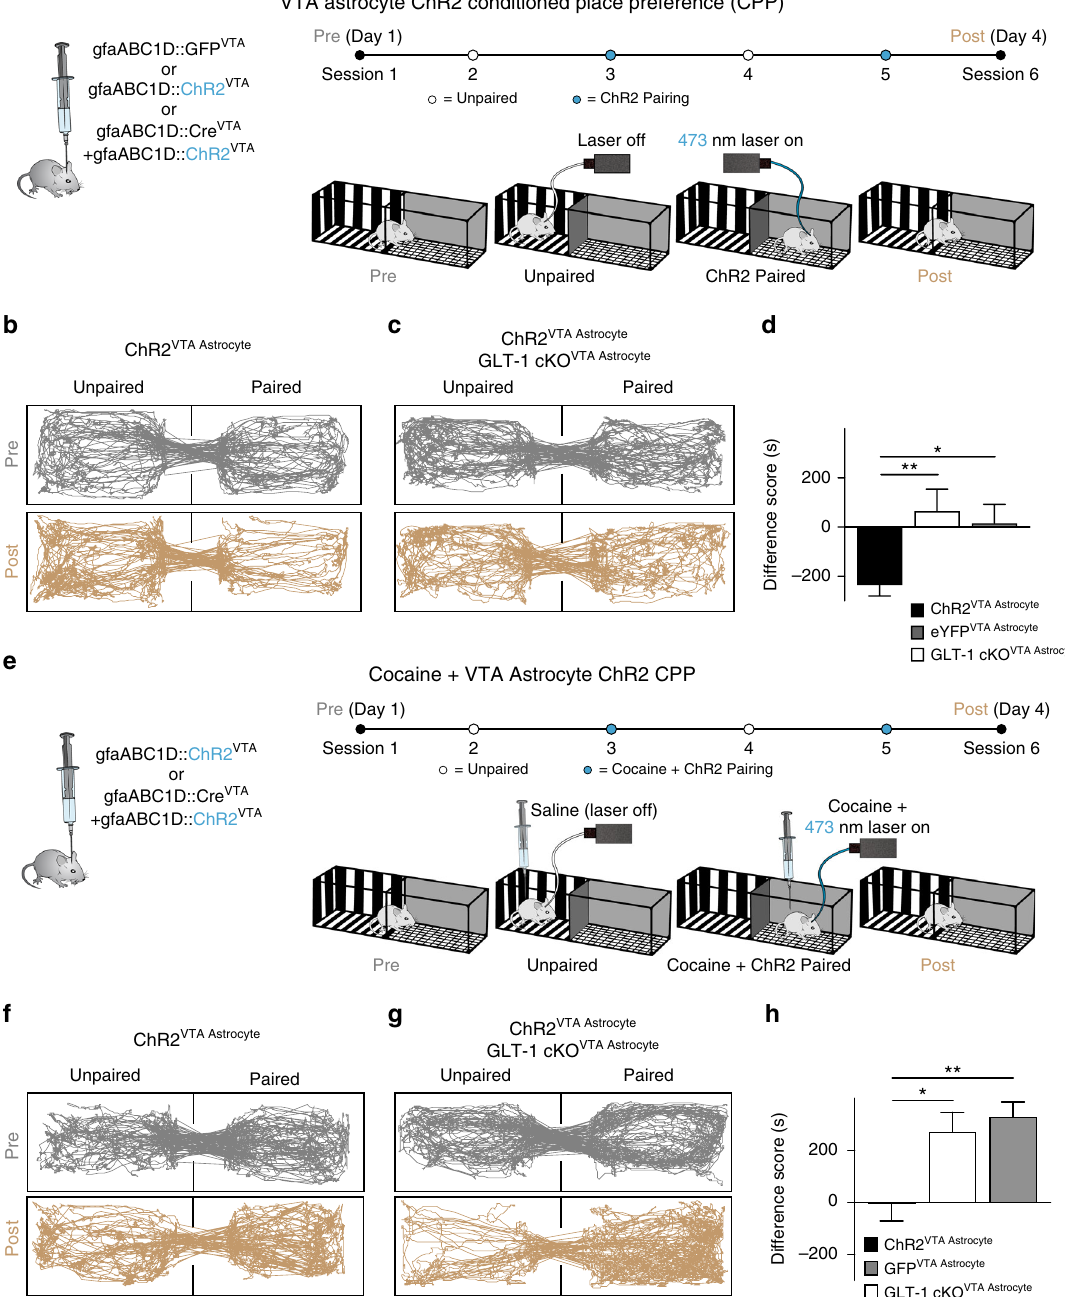
Fig. 7 VTA Astrocytes mediate learned avoidance and prevent learned preference for reward. a Experimental design and manipulations for panels b – d . b Track plots showing that conditioning with ChR2 photoactivation on VTA astrocytes elicits learned avoidance in a GLT-1 + / + mouse (gfaABC1D:: ChR2 VTA ). c The learned avoidance is absent in a mouse where GLT-1 was removed from VTA astrocytes (gfaABC1D::ChR2 VTA , GLT-1 cKO VTA Astrocyte ). d Comparing the difference scores in mice expressing either ChR2 (GLT-1 + / + and GLT-1 f/f , GLT-1 cKO VTA Astrocyte ) or GFP (gfaABC1D::ChR2 eYFP ) in VTA astrocytes. e Experimental design and manipulations for panels f – h . f Track plots showing astrocyte activation paired with cocaine administration does not elicit either learned avoidance or preference in a GLT-1 f/f mouse (gfaABC1D::ChR2 VTA ). g However, when GLT-1 is removed from VTA astrocytes (gfaABC1D::ChR2 VTA , GLT-1 cKO VTA Astrocyte ) a mouse displays robust learned preference for VTA astrocyte ChR2 photoactivation paired with cocaine administration. h Comparing the difference scores in mice expressing either ChR2 (GLT-1 + / + and GLT-1 f/f , GLT-1 cKO VTA Astrocyte ) or GFP (gfaABC1D:: ChR2 eYFP ) in VTA astrocytes. ** P < 0.01, * P < 0.05; Error bars indicate ±